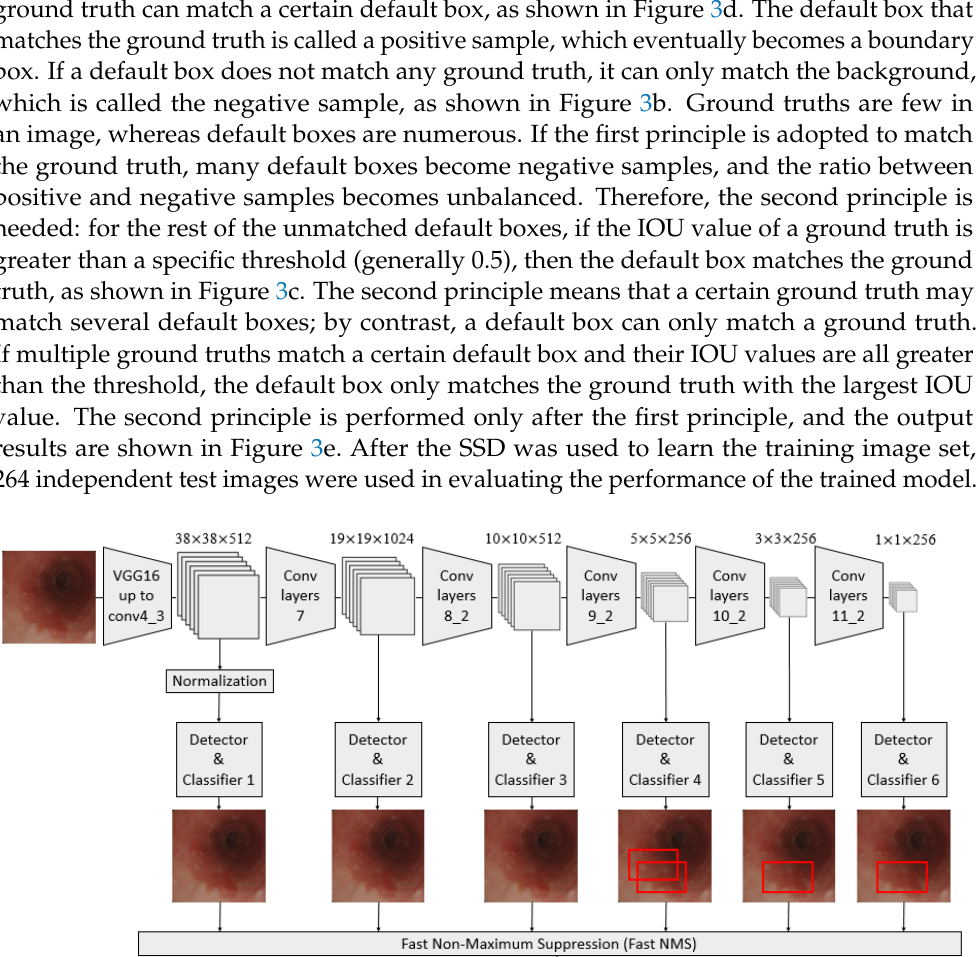
Figure 2. Schematic of the settings of the default box. Taking the midpoint of each point on the feature map as the center, a series of square prior frames with different sizes and the same center point was generated. With the square prior frame, the ground truth cannot be all square. If the